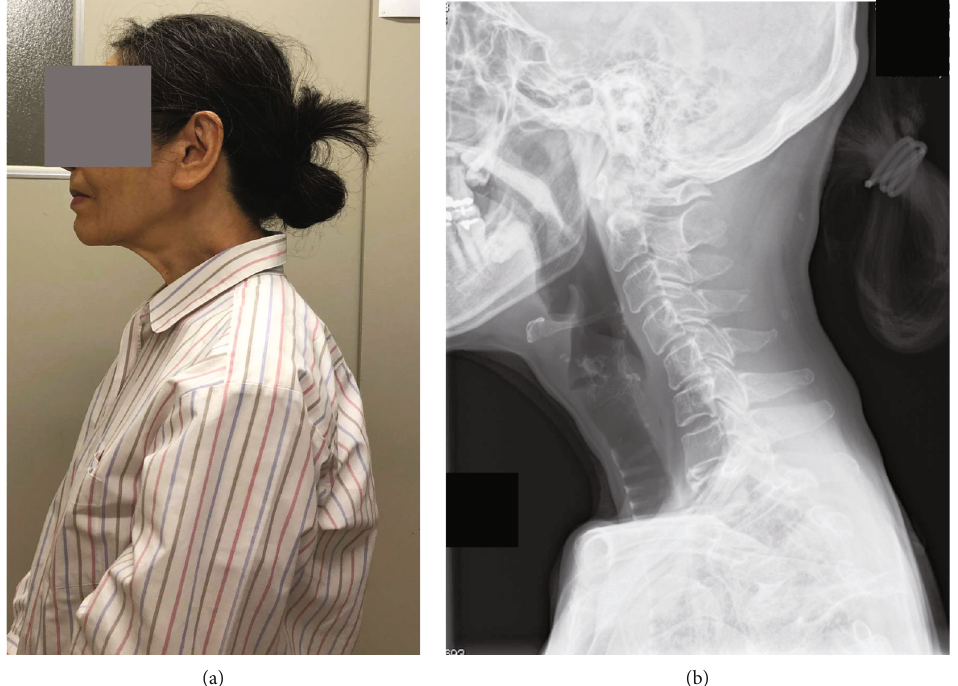
Figure 8: Lateral view of the patient ’ s neck (a) and her cervical lateral radiograph (b) seven months after the 1st AR-PT. (a) The patient ’ s neck posture was normal, and the muscle bulging had disappeared. (b) Forward inclination of her cervical spine was